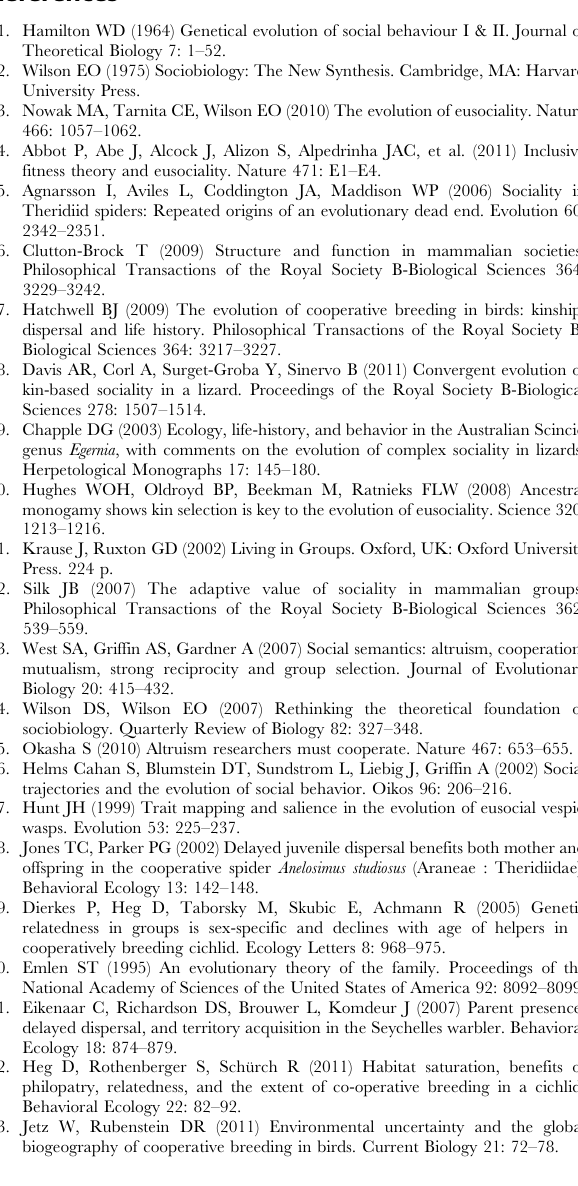
italicized for comparison. Estimates of survival are remarkably robust to changes in model structure; in all cases, the aggregated state is associated with higher survival than the solitary state. Table S2 Historical weather data for Pearblossom, CA, USA. Annual average and extreme minimum temperatures and number of nights below freezing from 1986–2009 (subset 2003– 2008 is the duration of this study). Source is NOAA National Climatic Data Center (NCDC) for the Pearblossom weather station ( #